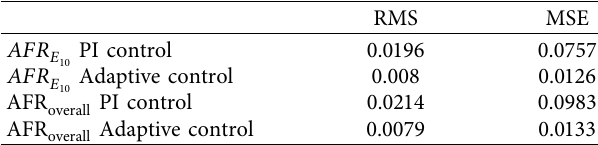
Table 3: AFR E 10 and AFR overall control errors.